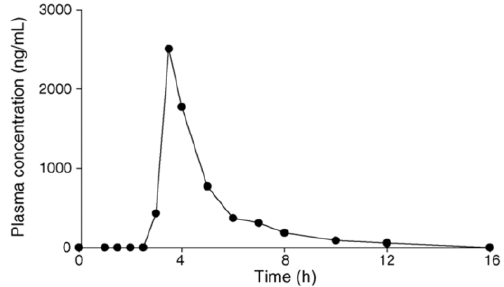
Figure 3. The mean plasma concentration time